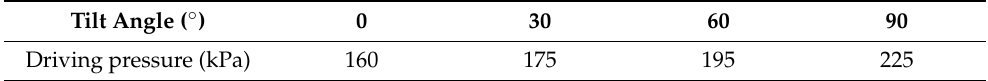
Table 6. Comparison table of pipe inclination and minimum driving pressure.